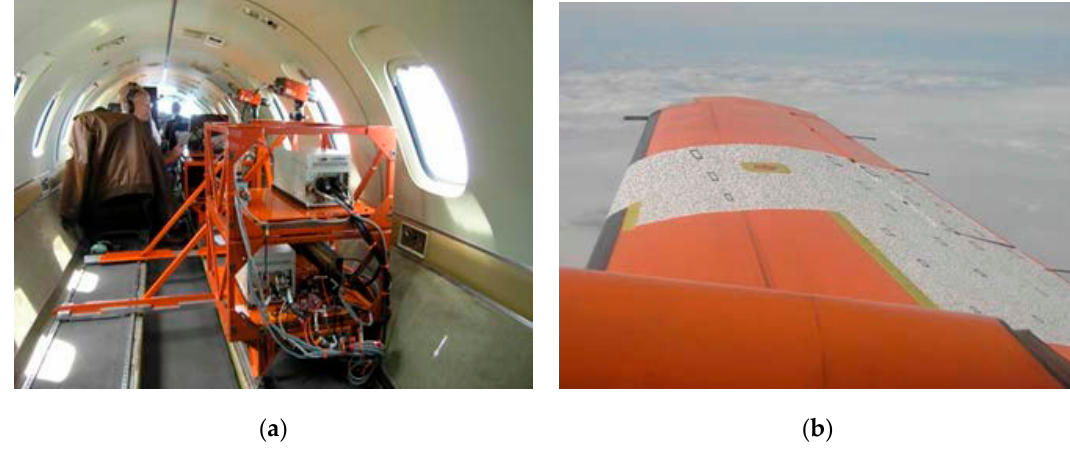
Figure 16. ( a ) The interior of the aircraft; ( b ) The partly speckled on the wing [65].